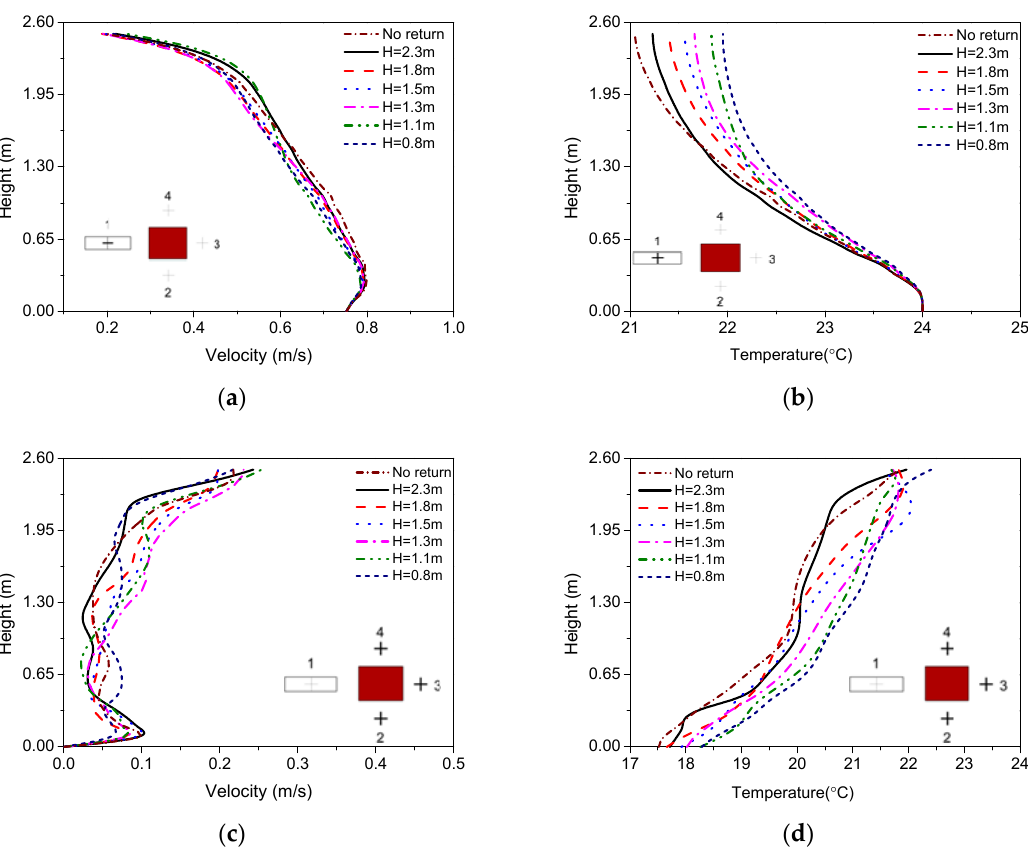
Figure 5. Effects of the return vent height on the air velocity and temperature profiles: ( a , b ) along Line 1 ( c , d ) in the vicinity of heaters.